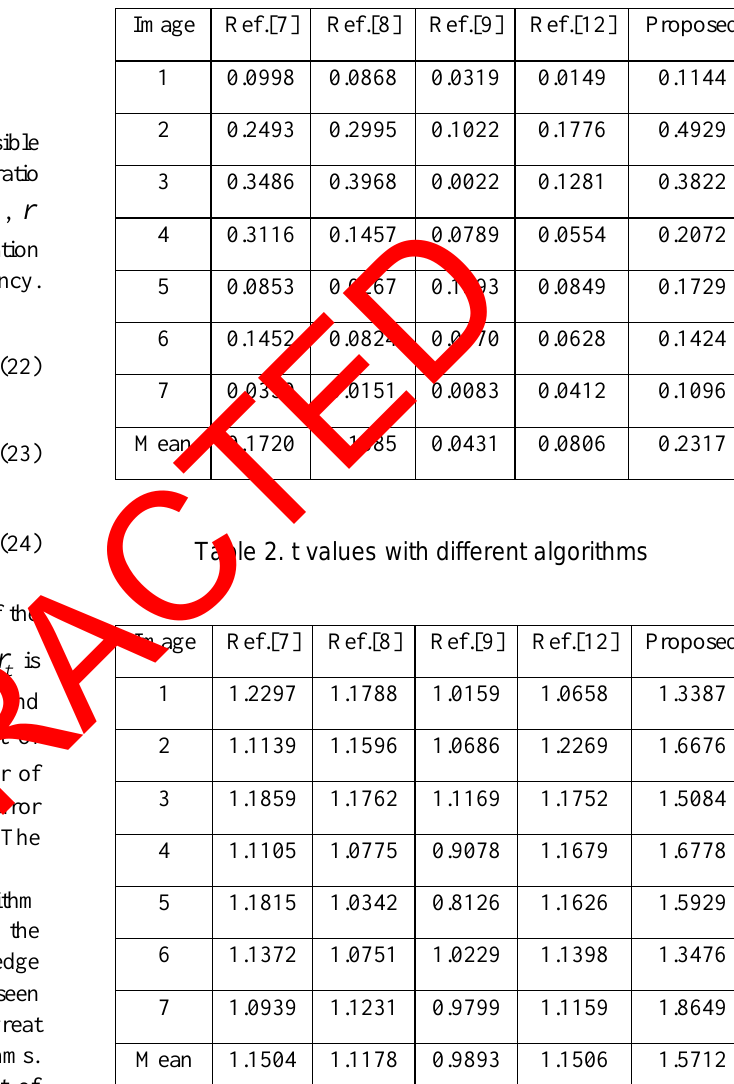
Table 1. p values with different algorithms